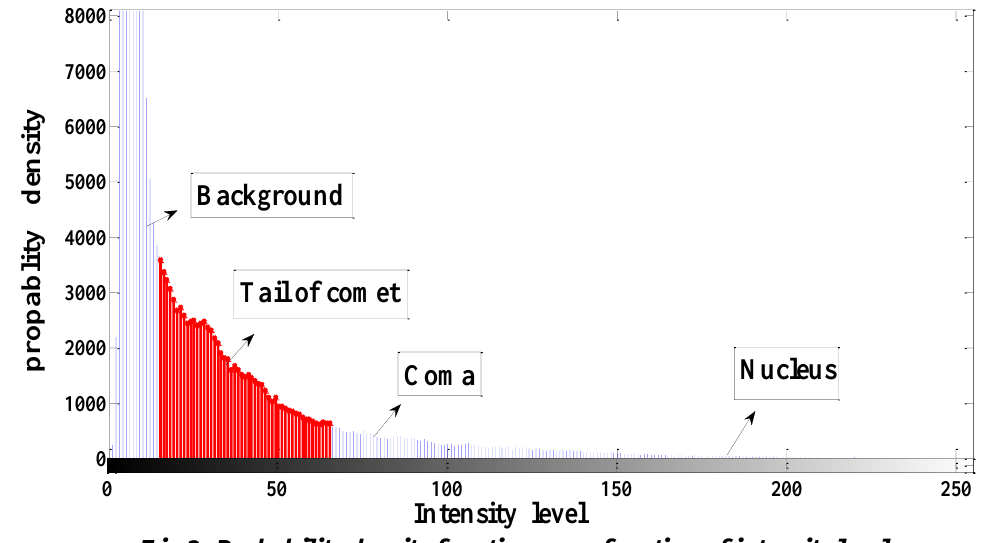
Fig.3: Probability density functions as a function of intensity